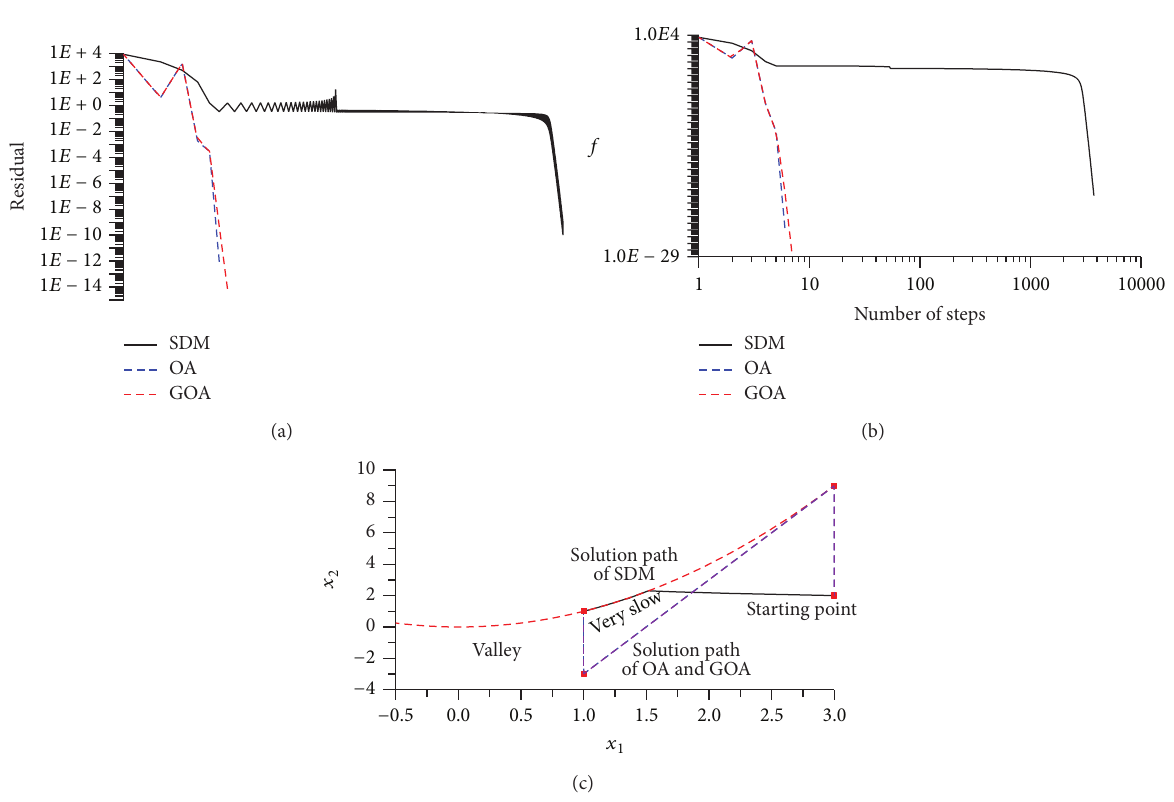
Figure 1: For the Rosenbrock problem, (a) the residuals, (b) the objective function 𝑓 , and (c) the solution paths of SDM, OA, and